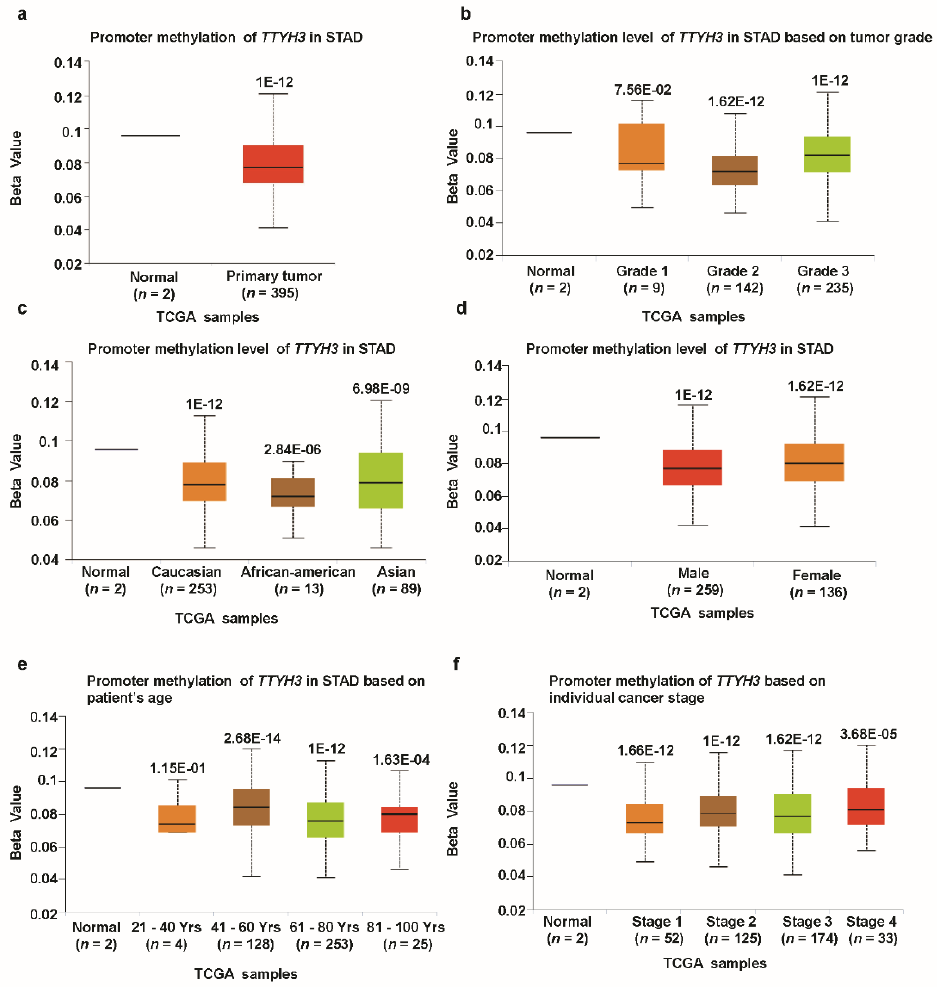
Figure 4. Promoter methylation of the TTYH3 gene is significantly downregulated in GC / SC tissue (TCGA data). Promoter methylation levels of the TTYH3 gene expressed as box plots from TCGA clinical data according to categorized GC patient characteristics using the UALCAN web tool: ( a ) Promoter methylation of TTYH3 in GC tumor (di ff erent color plot) and their normal (blue plot) tissues based on ( a ) normal vs. primary tumor, ( b ) tumor grade, ( c ) patient race, ( d ) patient gender, ( e ) patient age, and ( f ) individual cancer stage. The beta value indicates the level of DNA methylation ranging from 0 (unmethylated) to 1 (fully methylated).